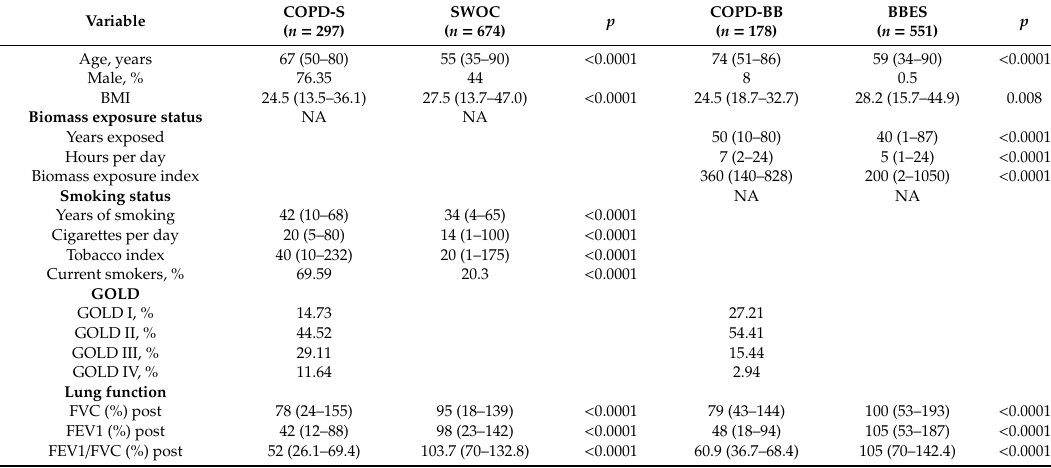
Table 1. Demographic variables and pulmonary function data from the four groups.